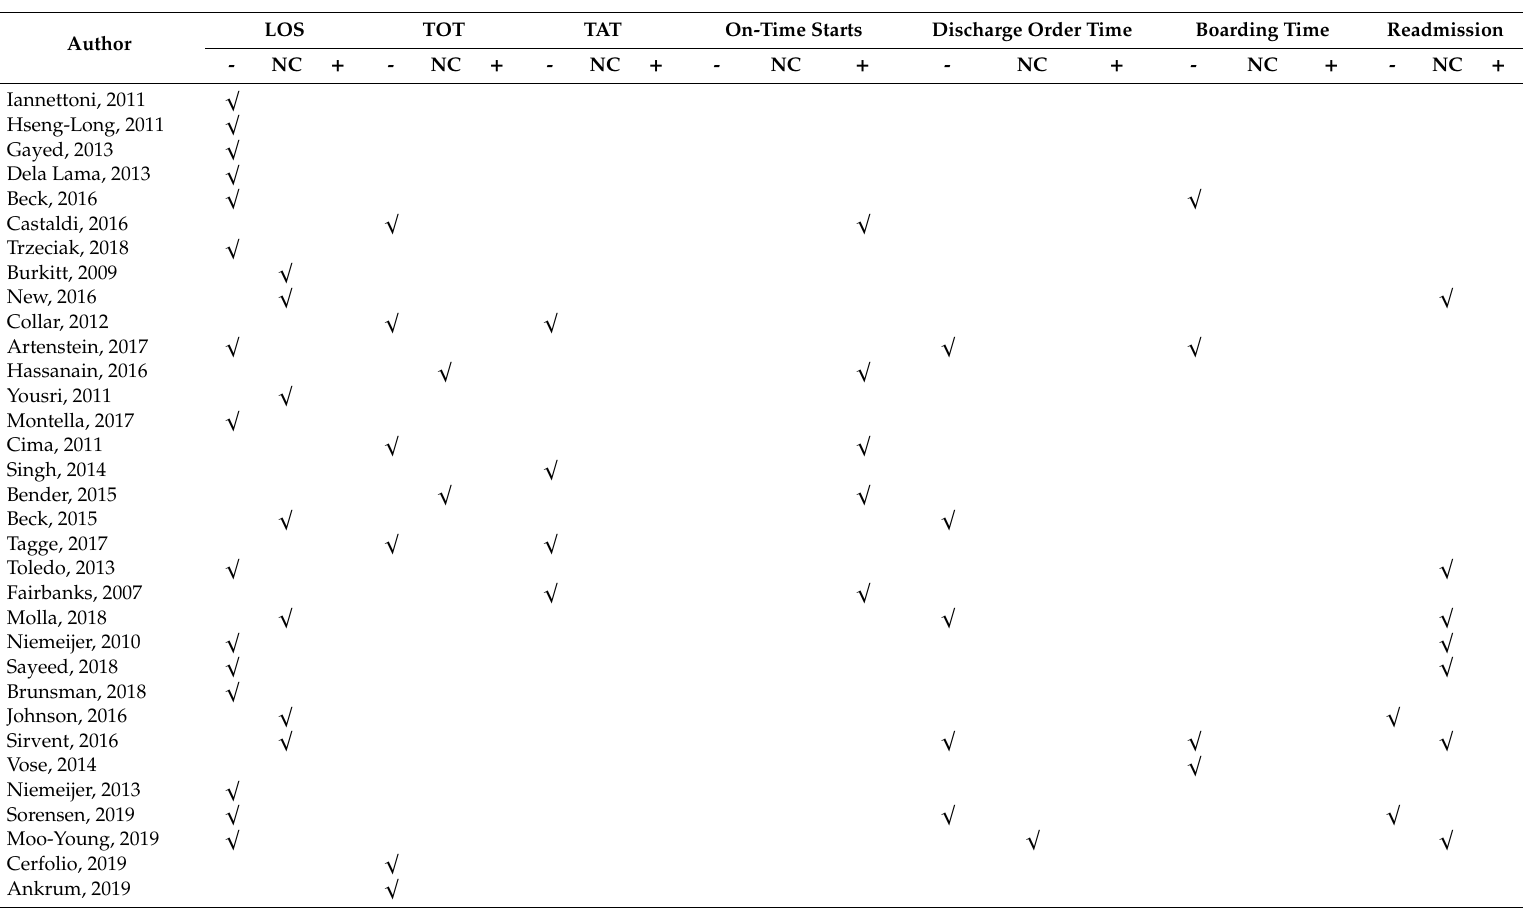
Table 1. Direction of Findings per Main